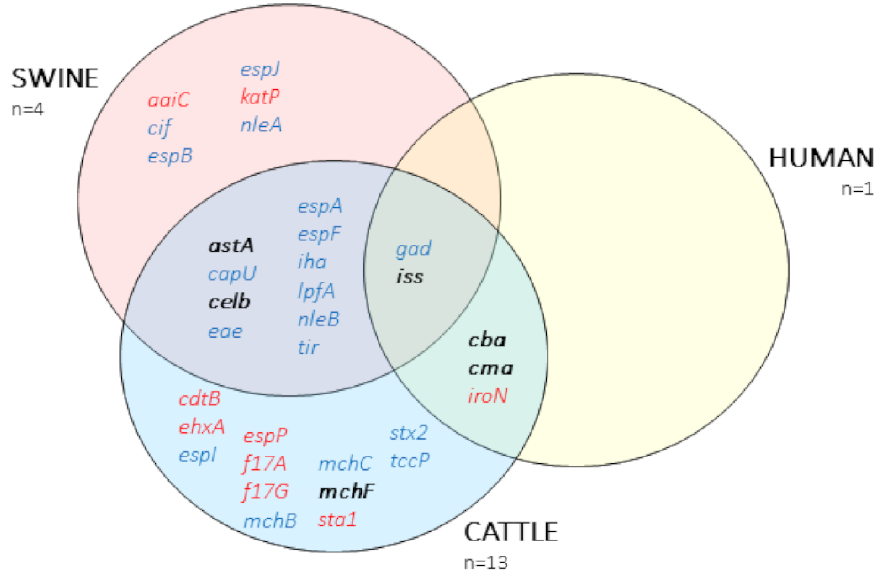
Figure 5. Venn diagram representing the virulence factors described by VirulenceFinder. Text in blue, chromosomal location; text in red, plasmid location; bold, located either in the chromosome or